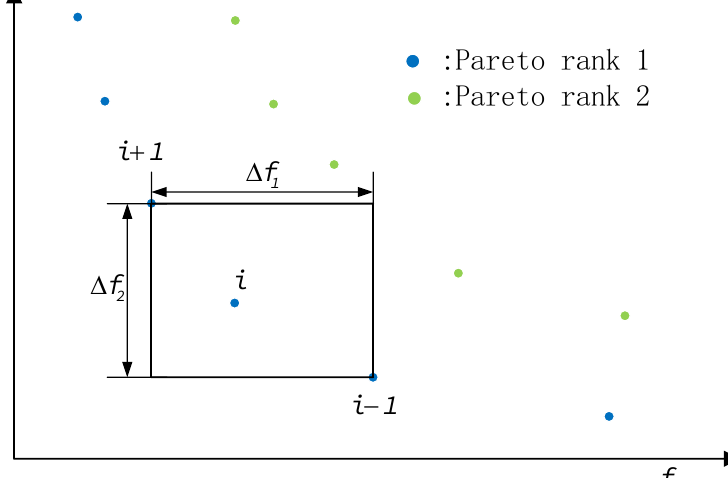
Figure 5. The crowding distance of the ith point.